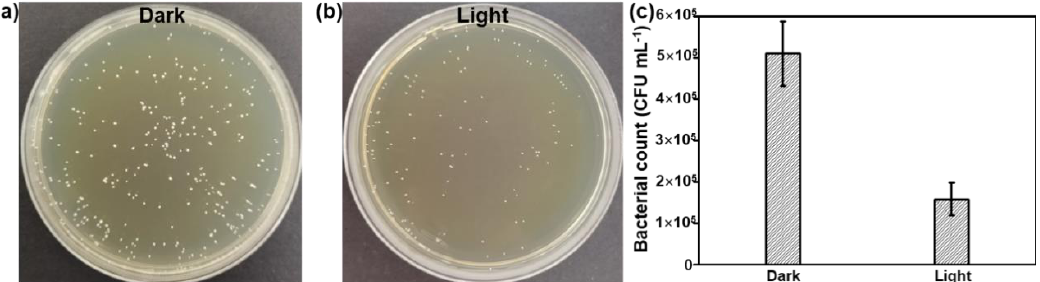
Figure 6. The antibacterial performance of the Bi QD/PDMS-modified tooth. Plate photographs of S. mutans for the Bi QD/PDMS-modified tooth incubated for 24 h ( a ) in the dark and ( b ) under light with a power density of 12 mW cm −2 . ( c ) The comparison of the antibacterial performance for the Bi QD/PDMS-modified tooth with 400 ppm Bi QDs in the Bi QD/PDMS nanocomposite.